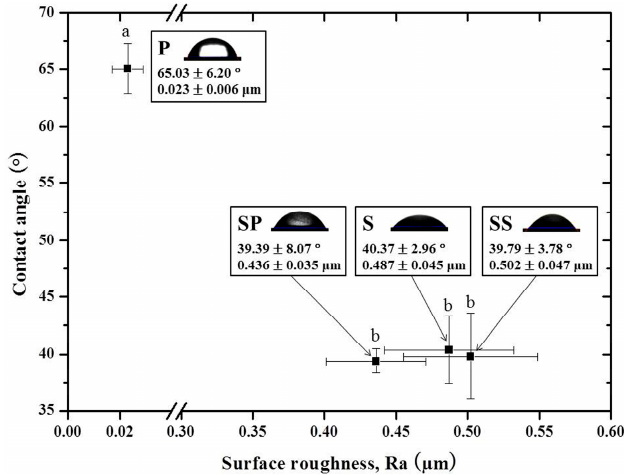
Figure 5. Contact angle as a function of surface roughness values after 3Y-TZP surface treatments. Bars indicate the standard deviation. P: Polishing; S: Sandblasting; SS: Sandblasting + SIE technique; SP: Sandblasting + MDP-containing silane primer. a, b: Groups shown with different letters were significantly different ( p < 0.05).